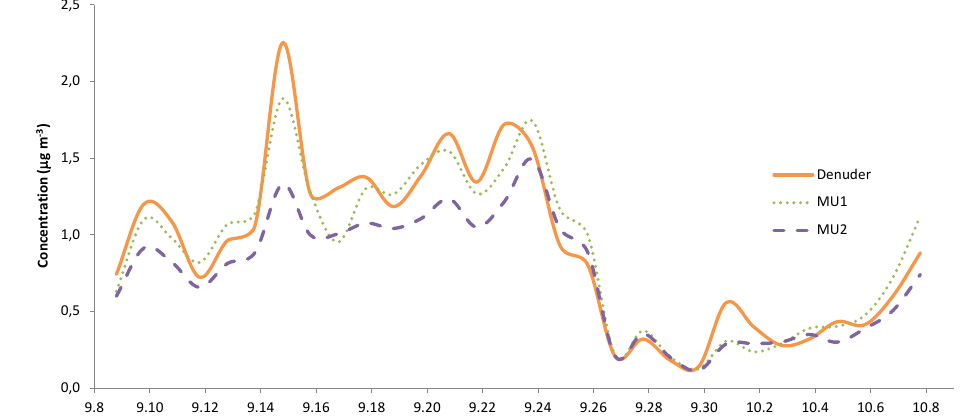
Fig. 13. Denuder and MUs measured 24 hour average HNO 3 concentrations during the ETV period. 2 Figure 13. Denuder and MU measured 24h average HNO 3 concentrations during the ETV period.